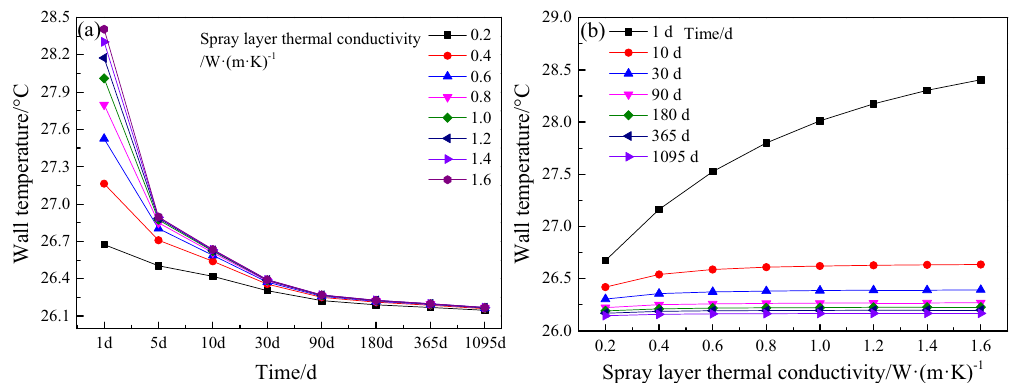
Figure 17: Influence of spray layer thermal conductivity on wall temperature: ( a ) wall temperature change with time; ( b ) wall temperature change with spray layer thermal conductivity.